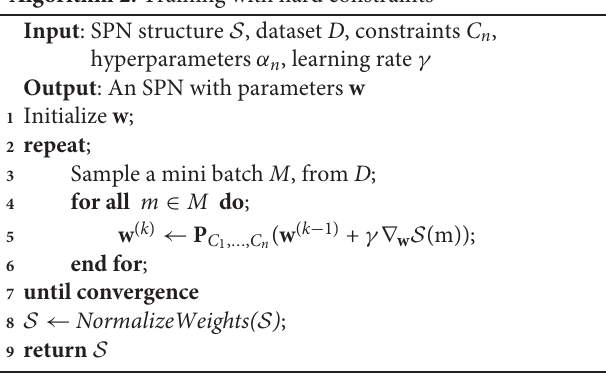
Algorithm 2: Training with hard